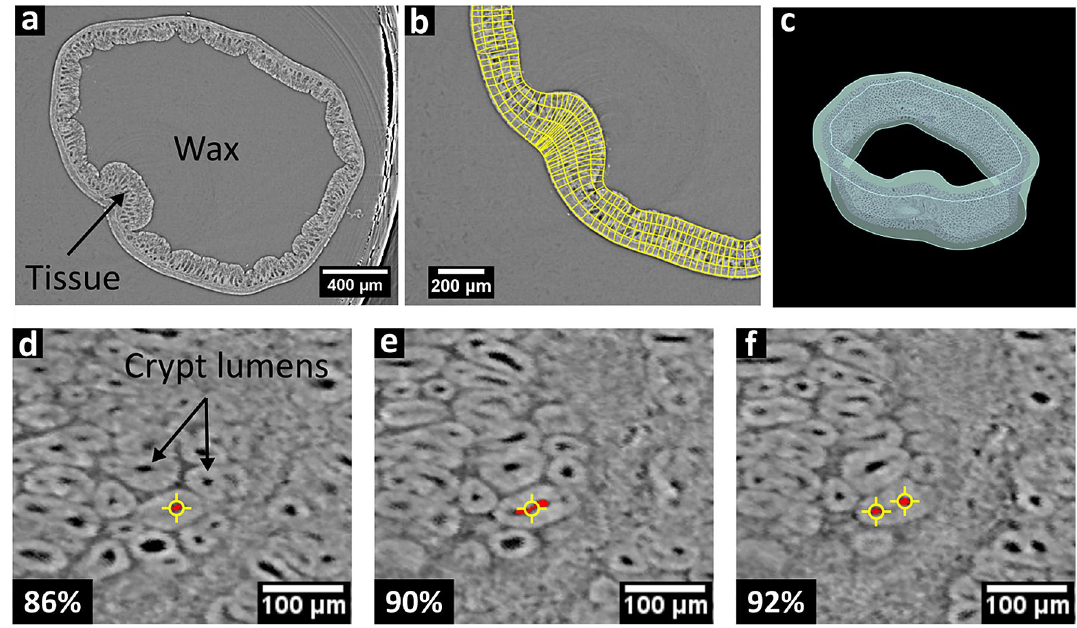
Figure 4:. 3D cycloramas for the study of murine colons. ( a-c ) A healthy murine colon embedded in paraffin wax. ( a ) A SR CT section of the intact colon. ( b ) Virtual electric field lines and the resulting contours ( C = 5 instead of the total C = 30 depth levels are shown here for visual clarity). ( c ) CT grey values are shown at 50% relative depth level, while boundary surfaces are shown transparent. ( d-f ) Unrolled CT stack of a murine colon with early stage colorectal cancer. The 3D cyclorama has a total of C = 50 slices or depth levels, where sequential slices at relative depth levels of 86%, 90% and 92% correspond to slices 42/49, 44/49 and 45/49, respectively. Crypt budding is revealed when a single colonic cross section, shown here in red, divides from one to several branches when moving from one slice to the next at a different colonic tissue depth, i.e., moving from e to f . Yellow crosses show points created inside individual budding crypts on each cyclorama slice. ( c ) Image c was created using Mayavi 46